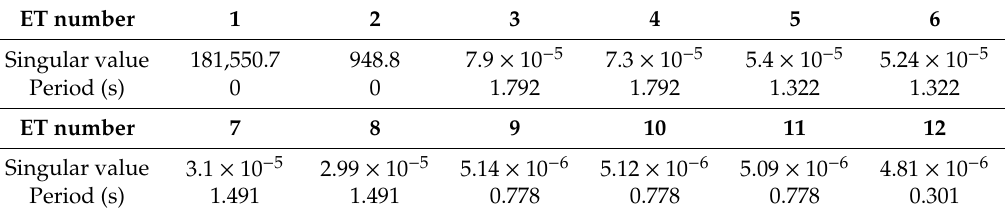
Figure 5. ( a ) Singular spectrum, ( b ) period spectrum in the simulation. Table 1. The period and singular value of eigentriples (number